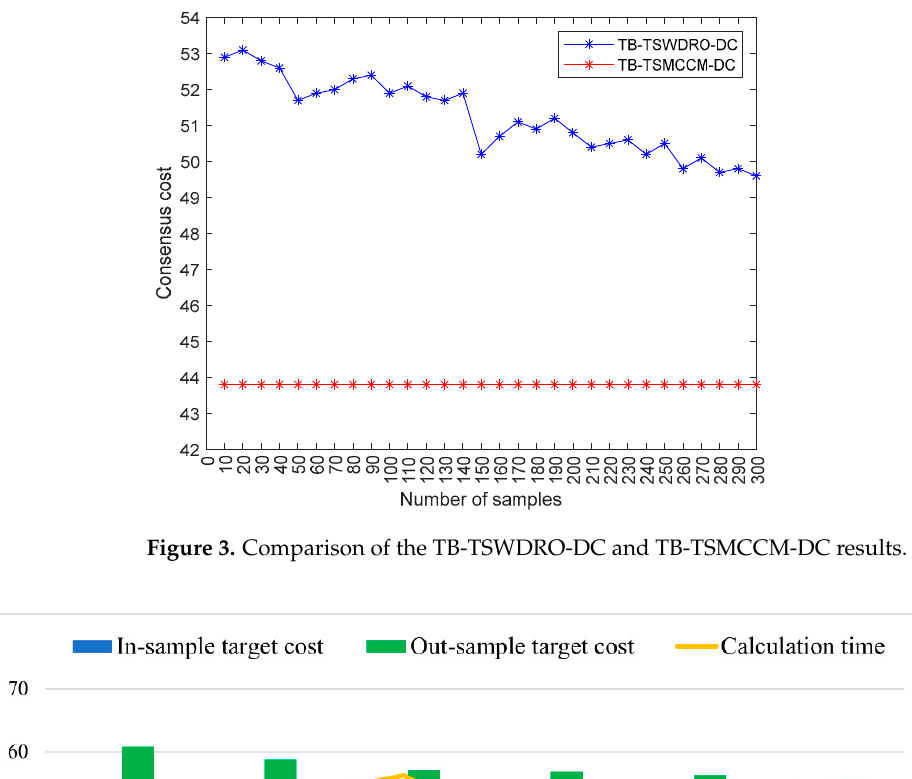
Figure 3. Comparison of the TB-TSWDRO-DC and TB-TSMCCM-DC results.